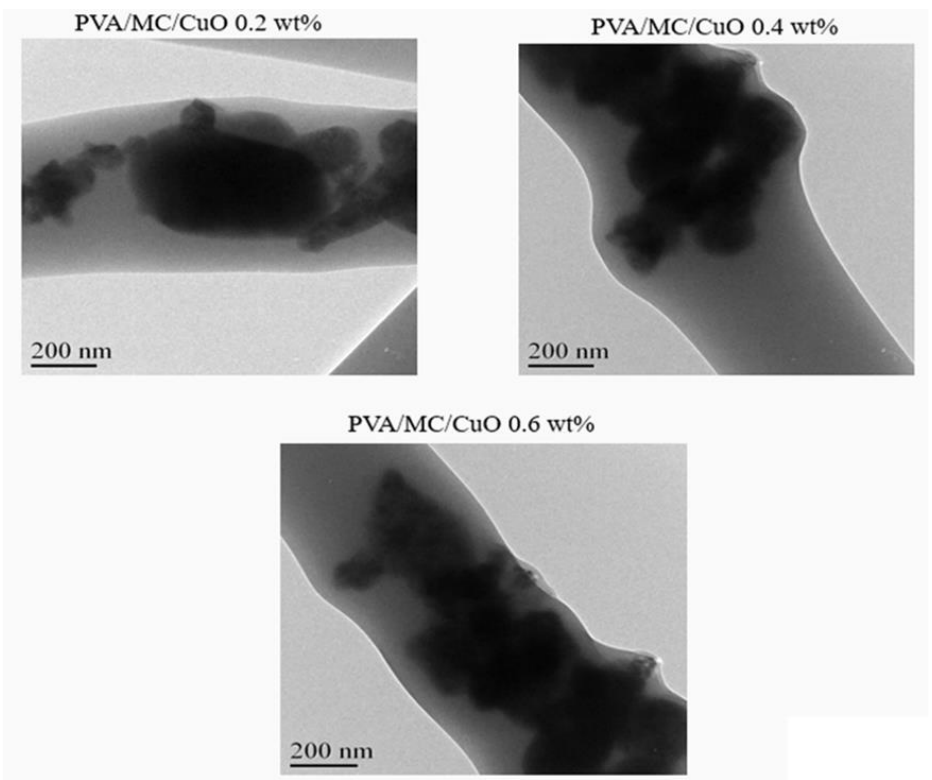
Figure 4. TEM images of the PVA/MC/CuO 0.2 wt.%, PVA/MC/CuO 0.4 wt.%, and PVA/MC/CuO 0.6 wt.% nanofibers.